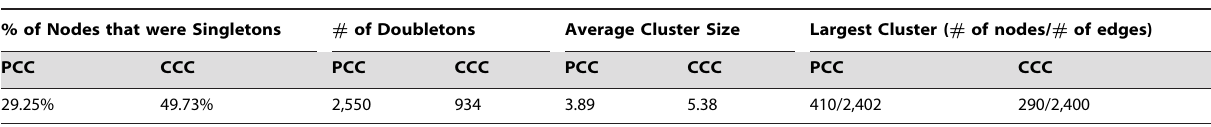
Table 3. Comparisons between PCC and CCC.